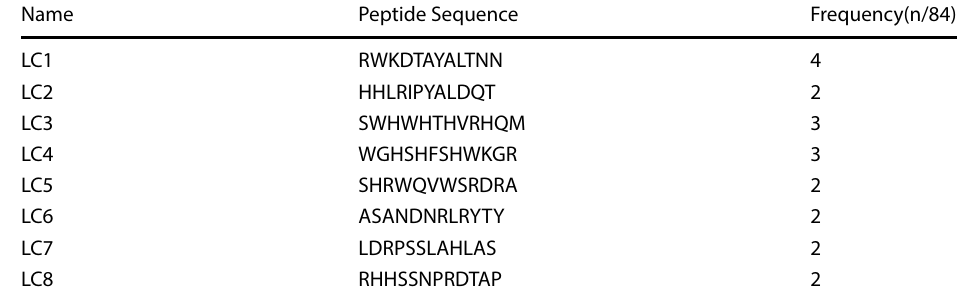
Table 1 Clone frequency and selected phage peptide